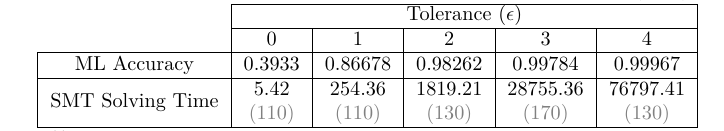
Table 2: Trade-off between ML tolerance and SMT solution time (sec.) for TRIVIUM